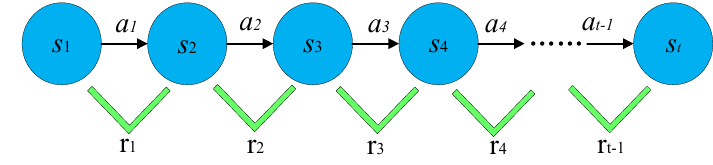
Figure 6 . The process of RL.